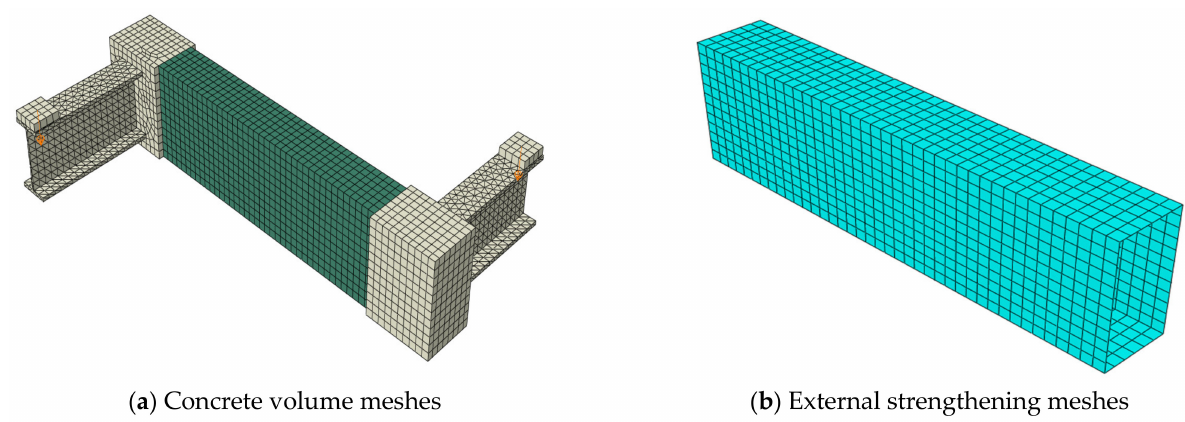
Figure 28. Meshes of beam